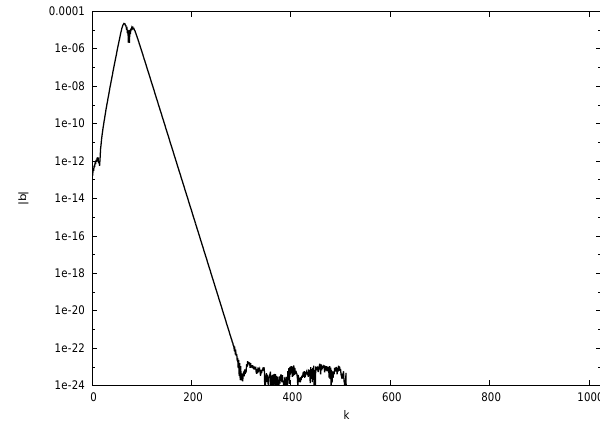
Figure 5. Initial Fourier spectrum | b k | of two breathers.